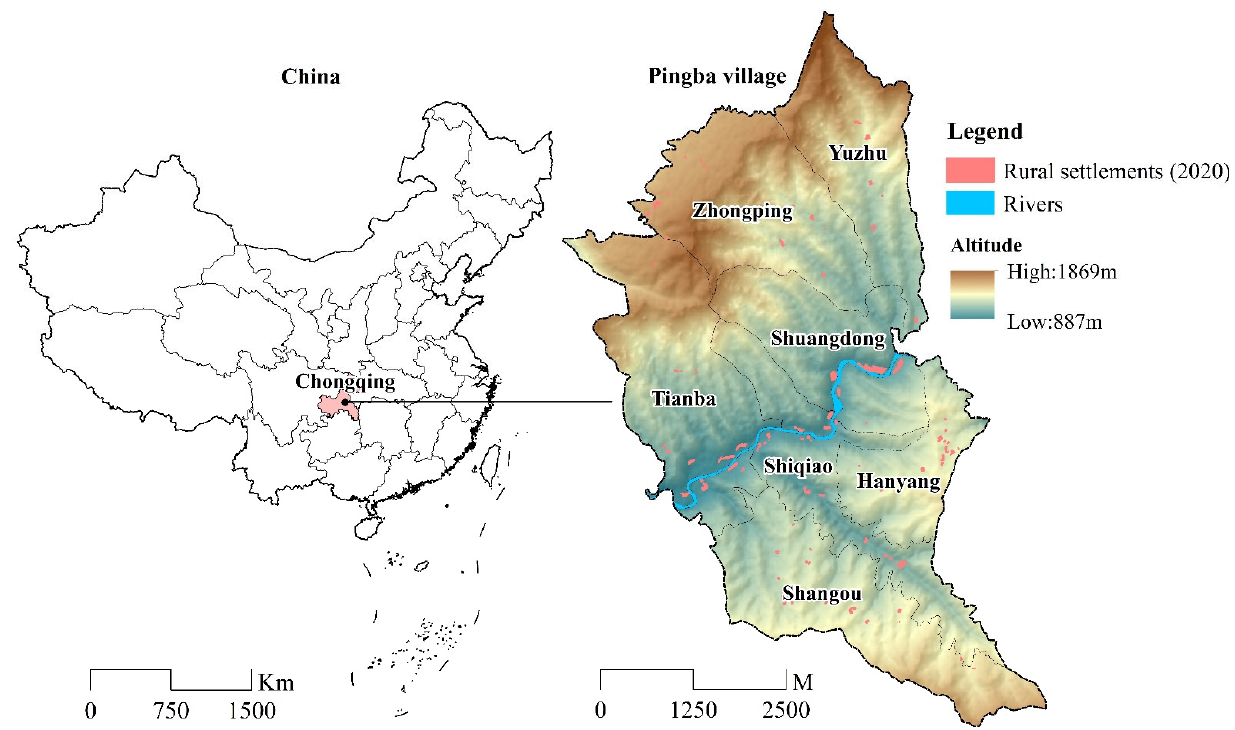
Figure 1. Location of the study